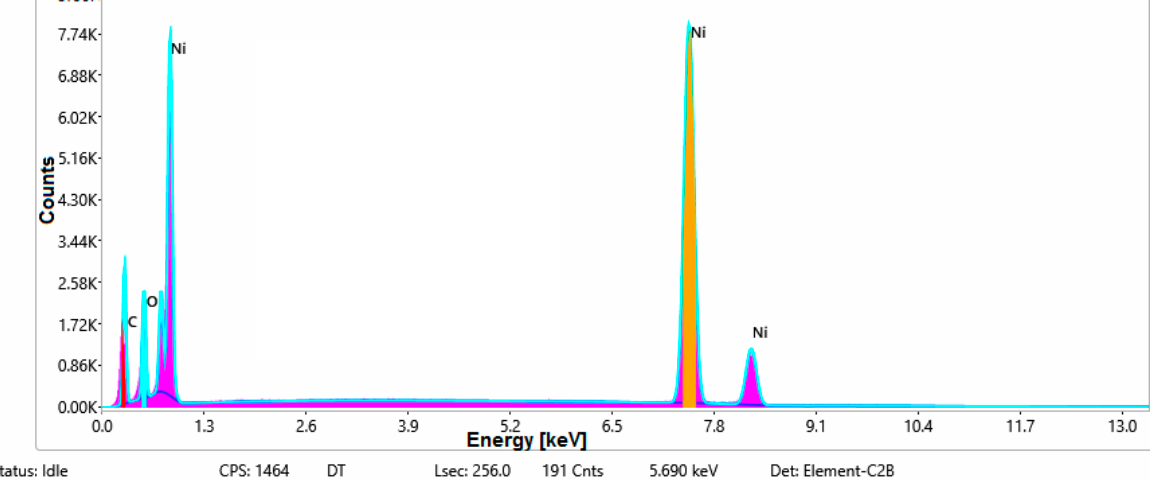
Figure 15. Smart elemental mapping overlay for sample S2 treated in RF plasma O 2 , using RF 1 generator and power 200 W and Ni paste.